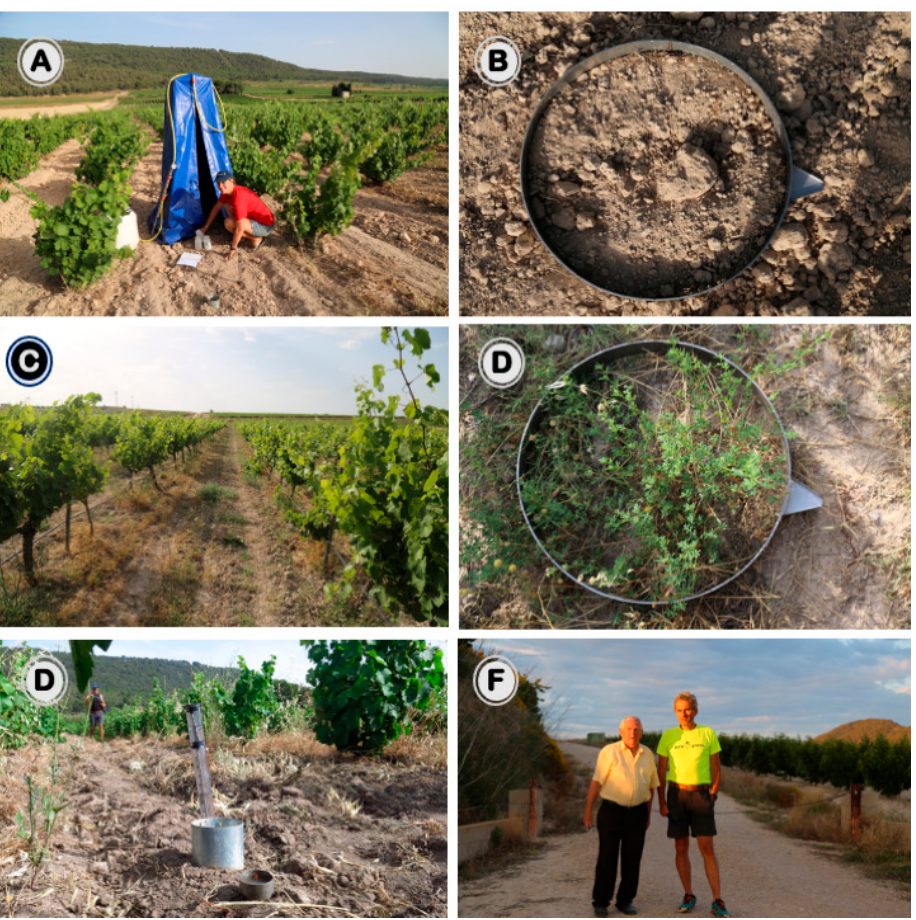
Figure 2. View of the study sites and experimental setup. ( A ). View of the control plot during the rainfall simulation experiments. ( B ). View of one rainfall simulation plot at the control plot. ( C ) View of the catch crop plot. ( D ). Rainfall simulation plot at the catch crop study site. ( E ). Ring infiltrometer measurements at the control plot. ( F) . Interview with a farmer.